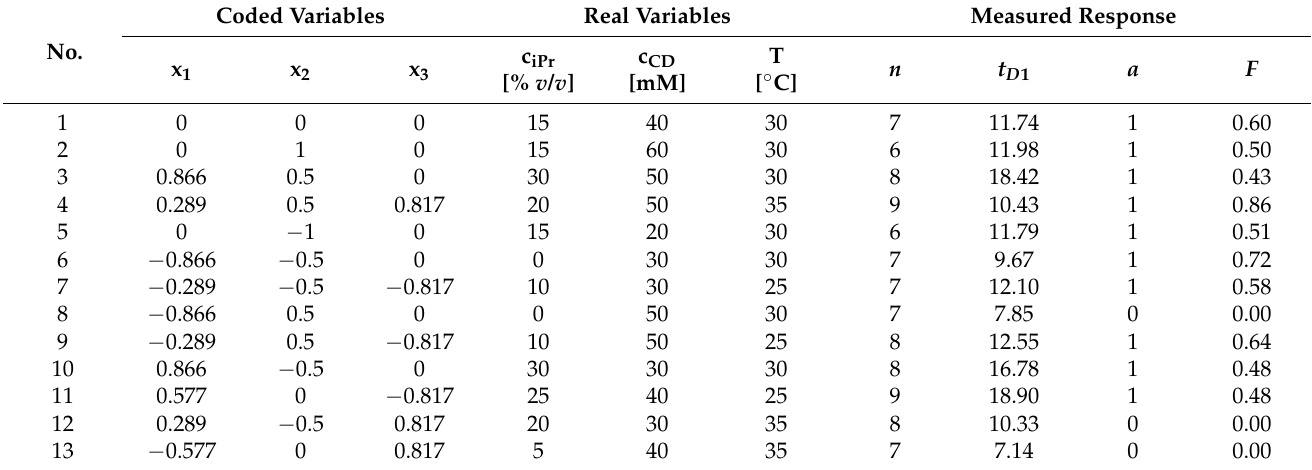
Table 1. Doehlert design with coded and real experimental values of variables and measured re- sponses; c iPr is the concentration of isopropanol and c CD is the total concentration of 2-hydroxypropyl- β -cyclodextrin (HP- β -CD) and 2-hydroxypropyl- γ -cyclodextrin (HP- γ -CD) mixed in a molar ratio 1:1, T is separation temperature, a is the parameter with values 1 or 0, F is the response